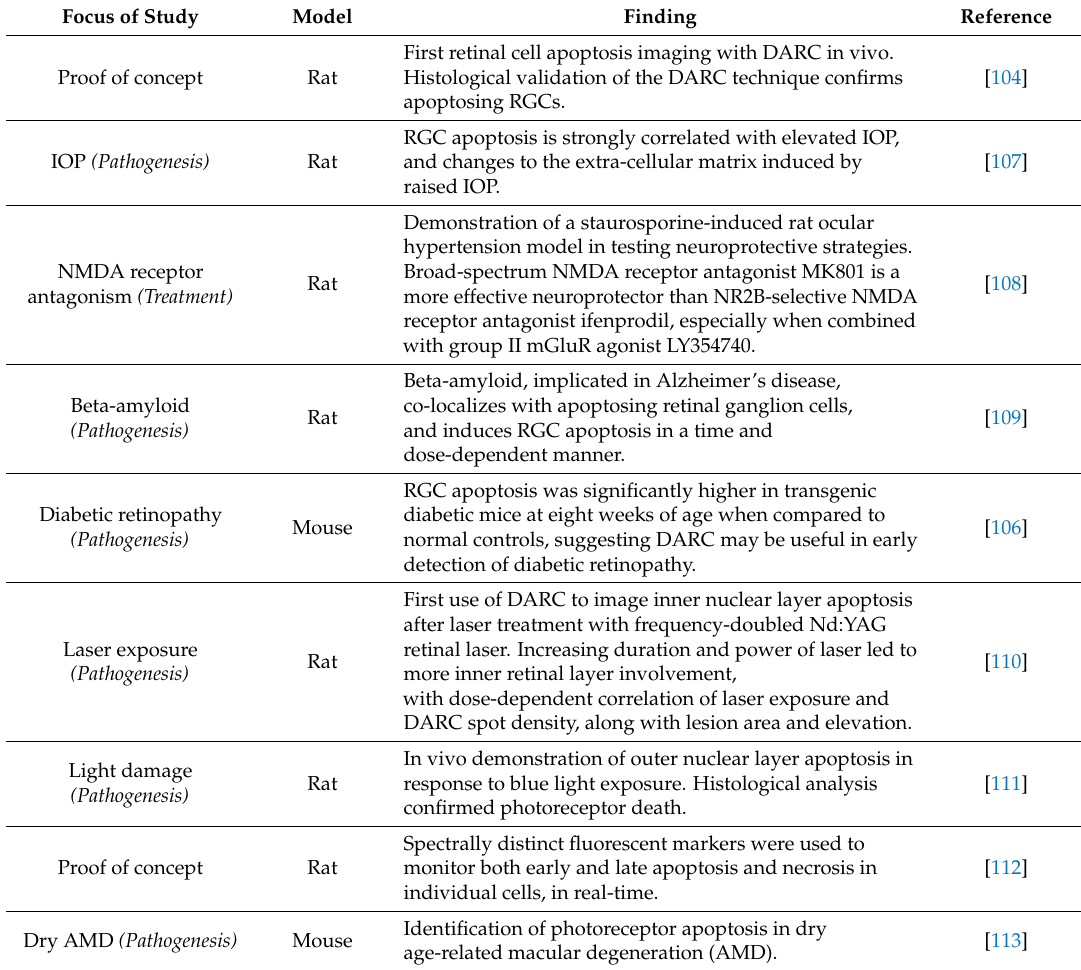
Table 1. Studies using DARC